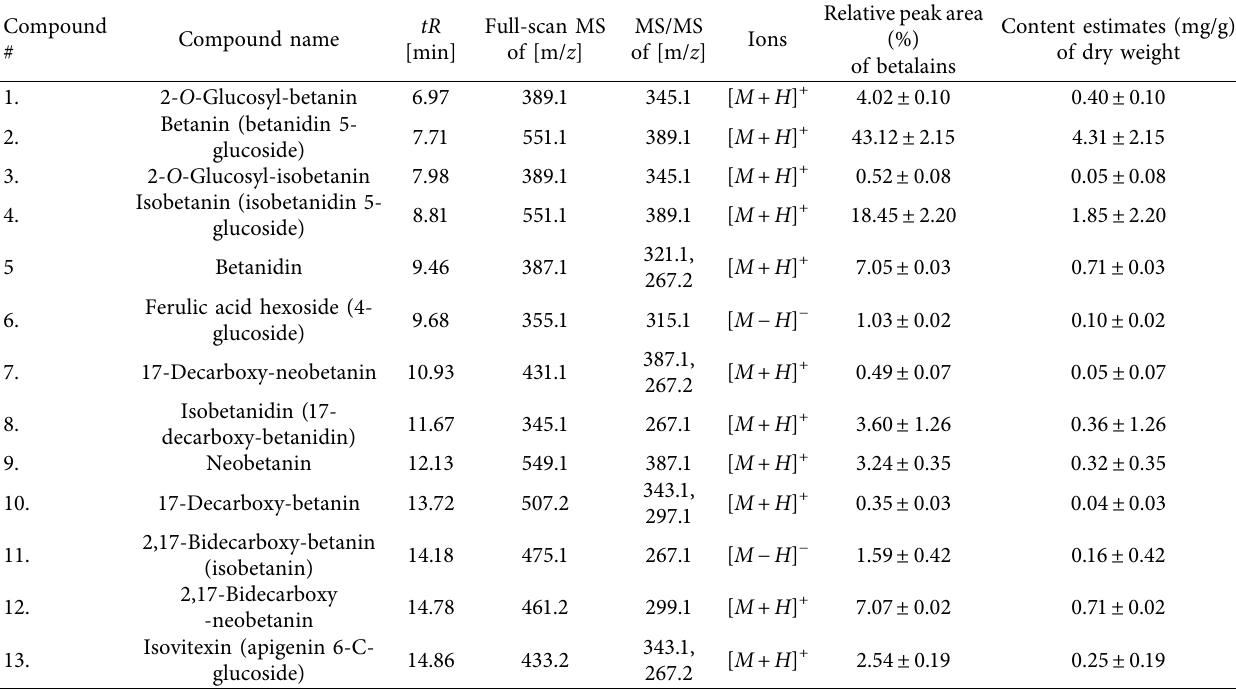
Table 6: Betalains identified in Beta vulgaris L. peels and pomaces extract by LC-MS/MS.